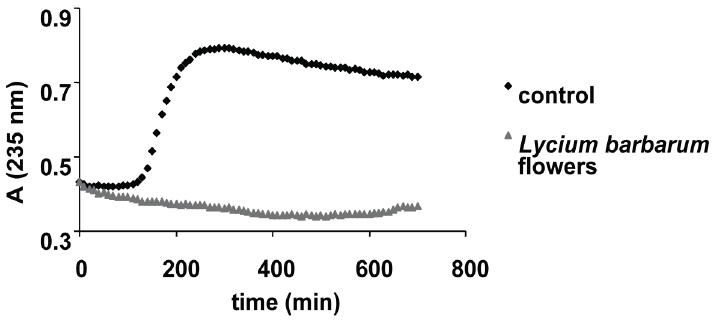
Figure 2. Liposome oxidation by cytochrome c , in the presence of the tested sample.